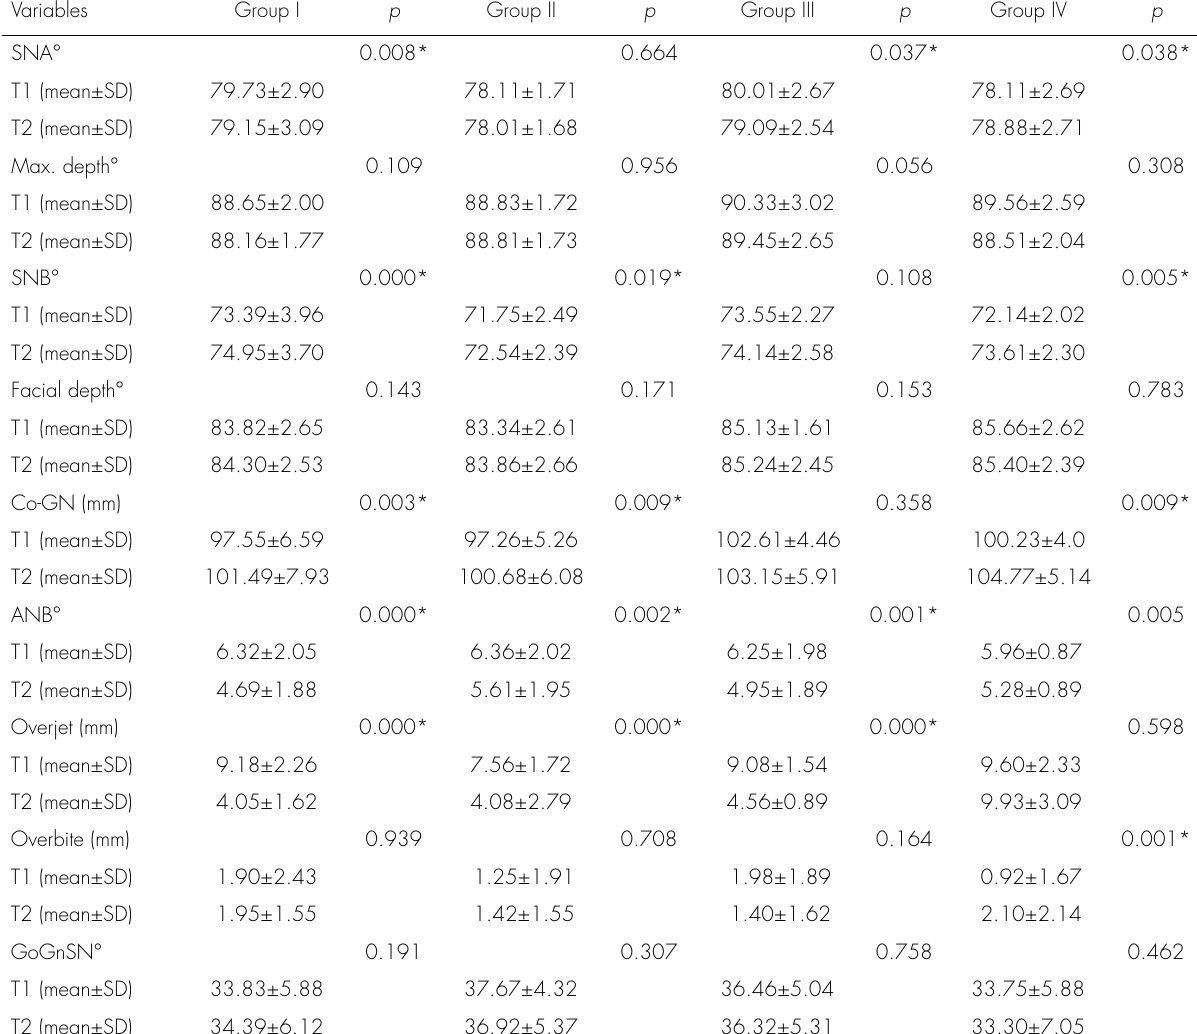
Table II. Pre- (T1) and post-treatment (T2) skeletal measurements of each group.